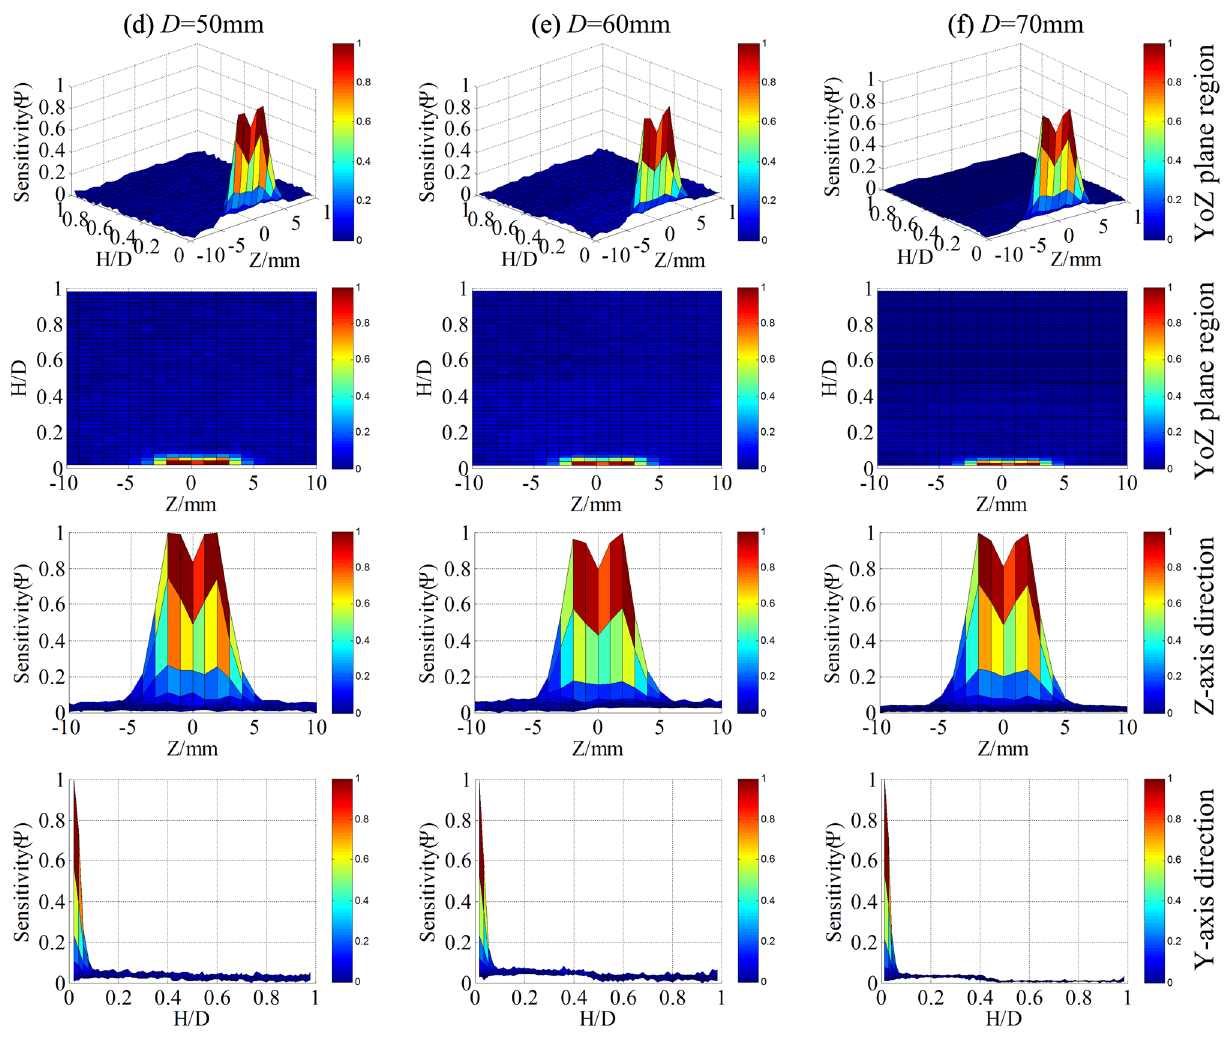
D 1 under six different